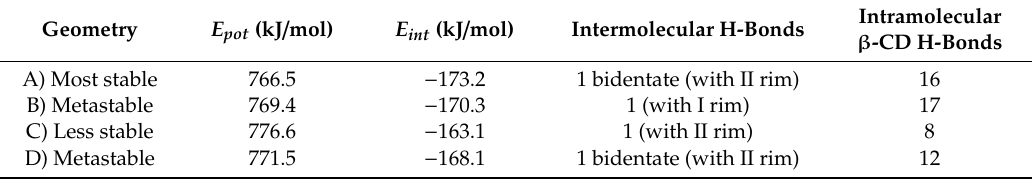
Table 1. Potential energy and interaction energy in kJ / mol calculated in the optimized geometries assumed at the end of the MD runs for the most and the less stable final geometries. Intermolecular β -CD / PX H-bonds and intramolecular β -CD H-bonds are